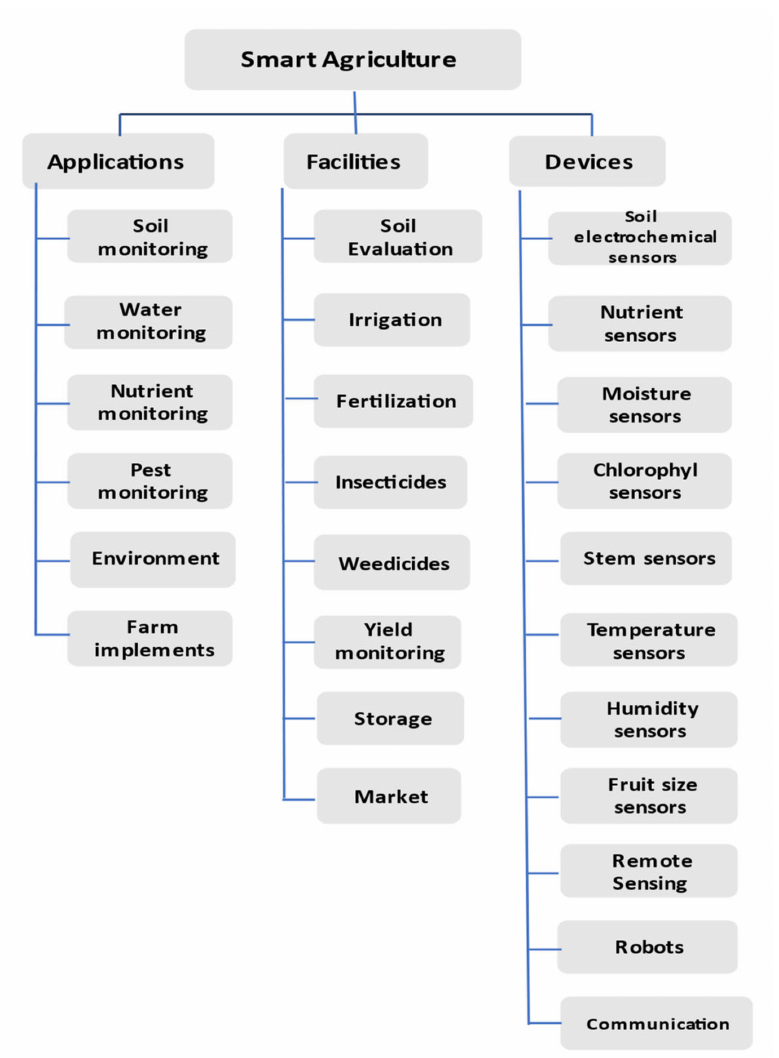
Figure 5. Hierarchy of probable applications, facilities and devices for smart